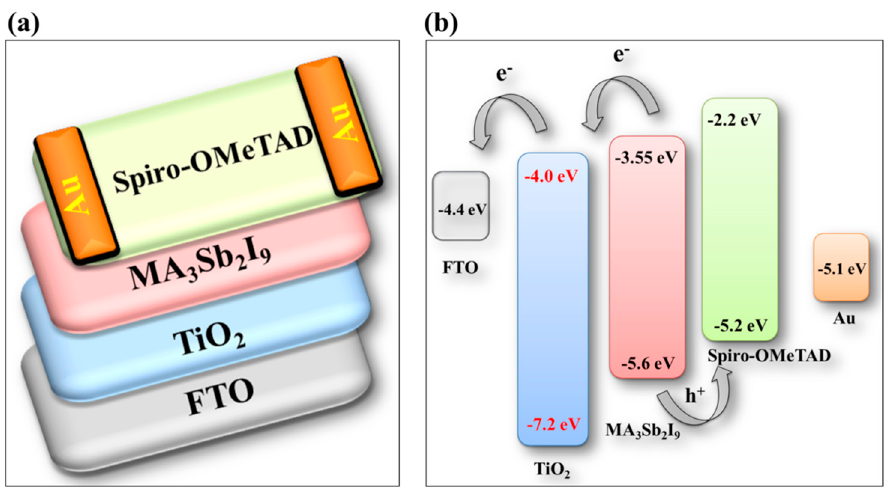
Scheme 1. Schematic device structure ( a ) and energy level diagram ( b ) of the fabricated Pb 2+ free PSCs.